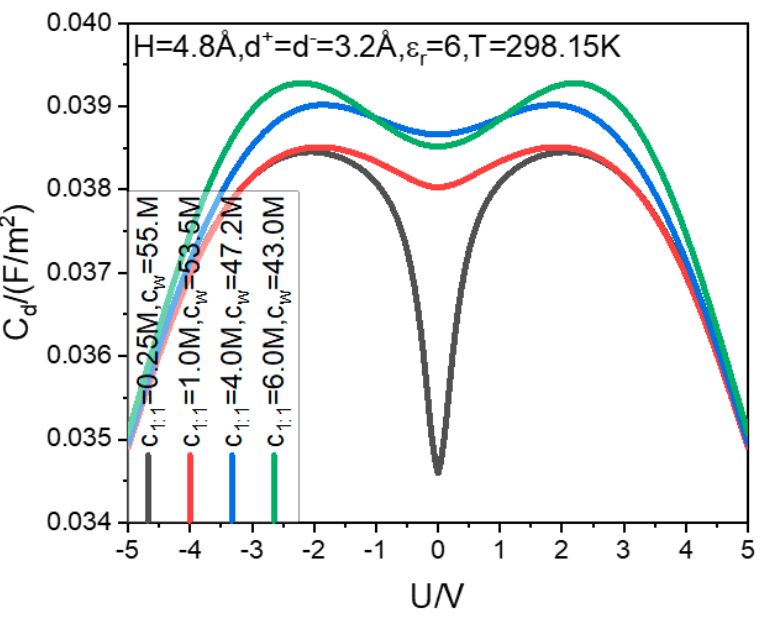
Figure 1. Correlation between the bulk electrolyte concentrations and differential capacitance–voltage curves.